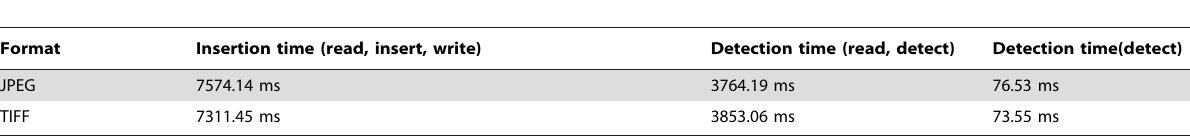
Table 4. Performance evaluation of insertion and detection of